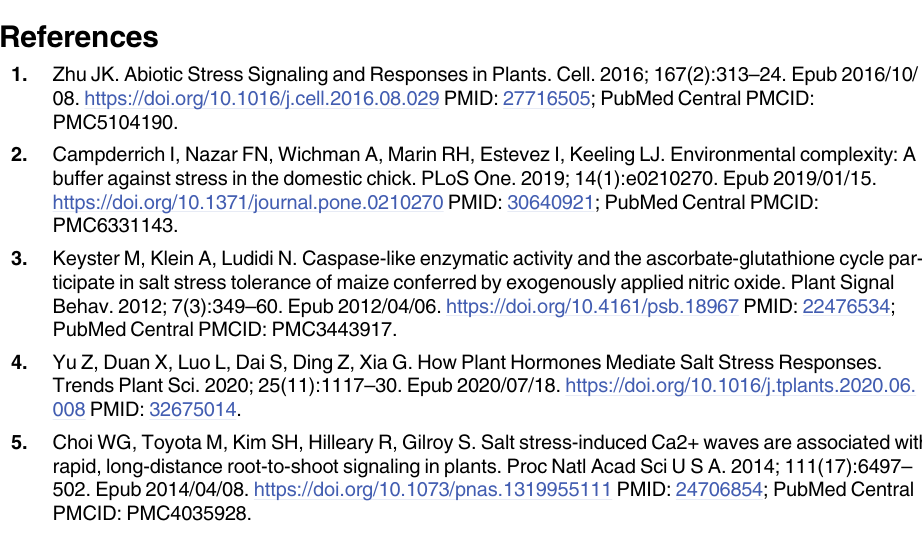
S2 Table. The detailed information of SRAS genes. S3 Table. Primers used in this study. S4 Table. SRAS1.1 and SRAS1.2